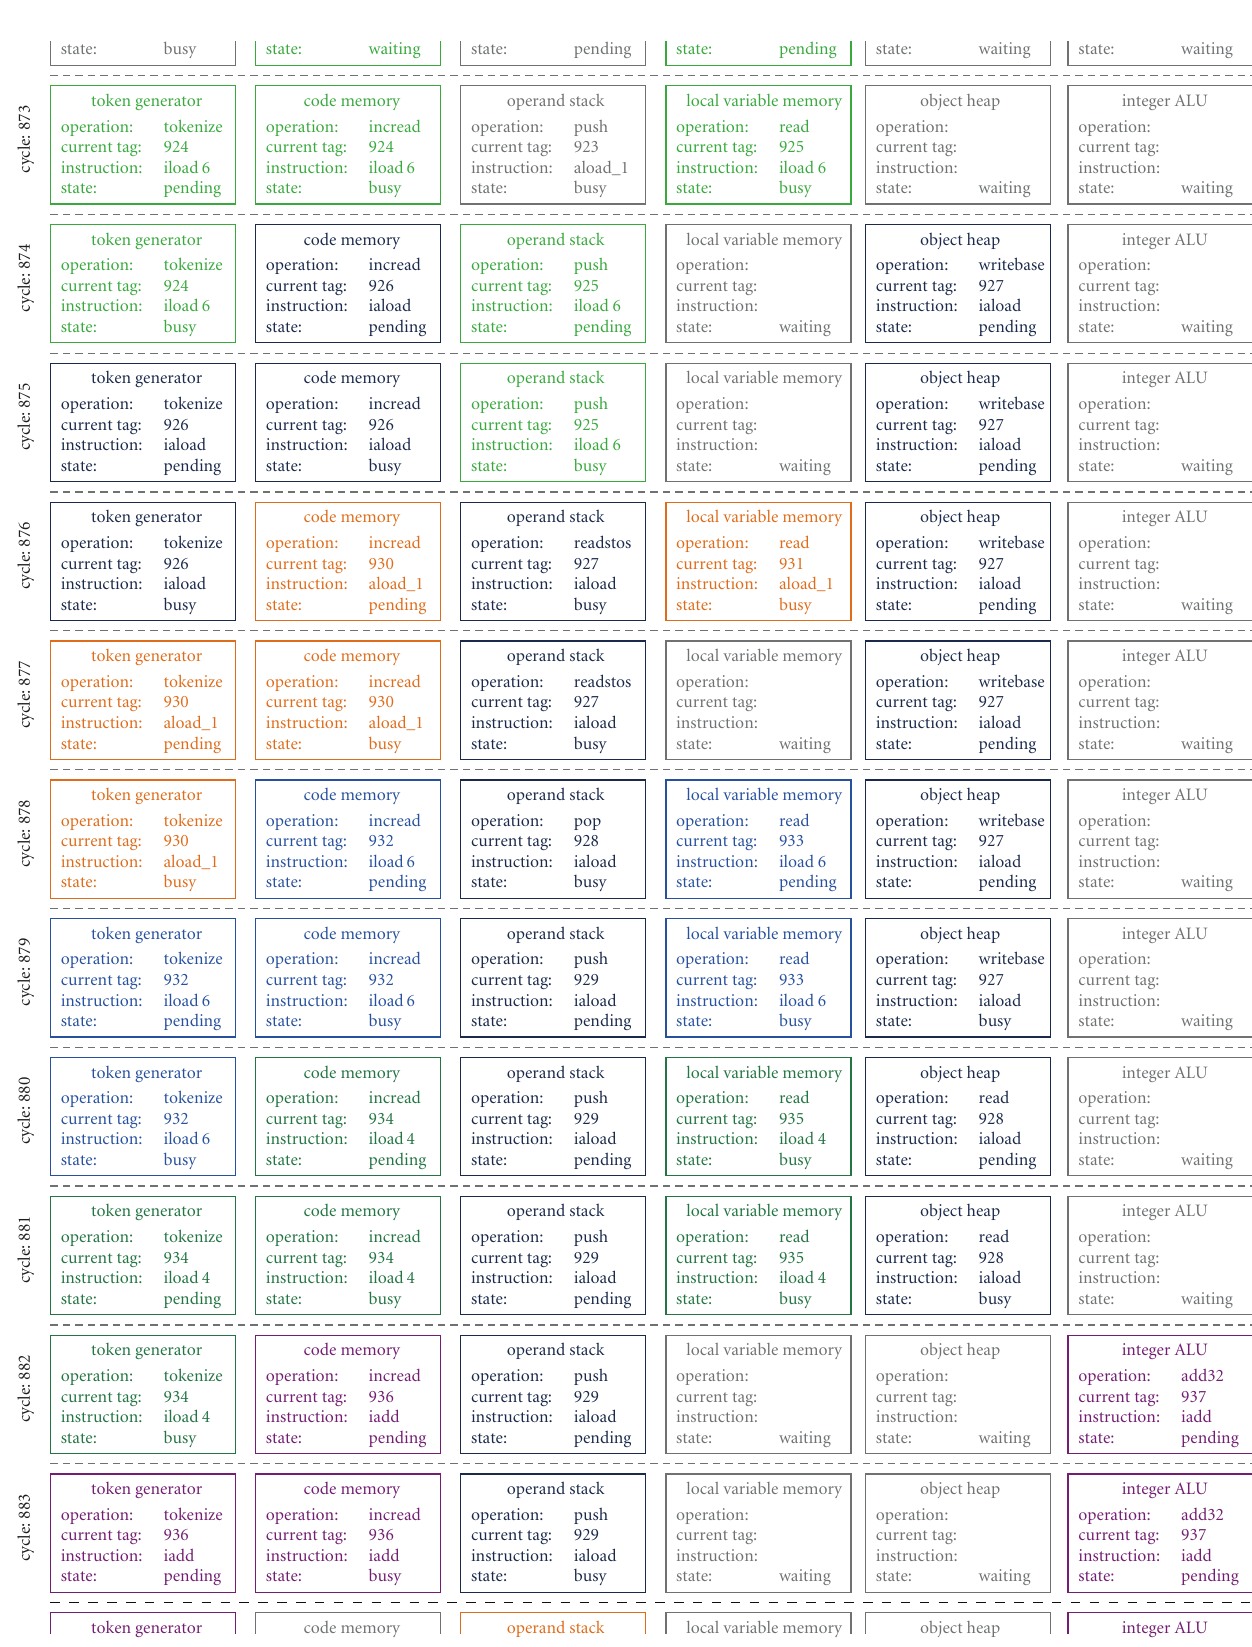
Figure 4: Visualized excerpt of an exeuction trace of the autocorrelation